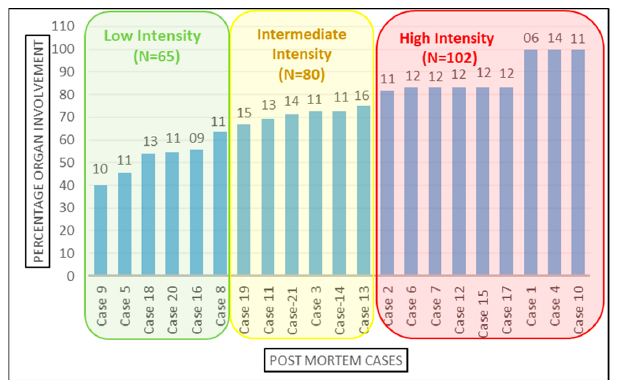
Figure 3. Categorization of the cases based on organ involvement. Numbers on top of the bars represents the total number of samples studied from the corresponding case.